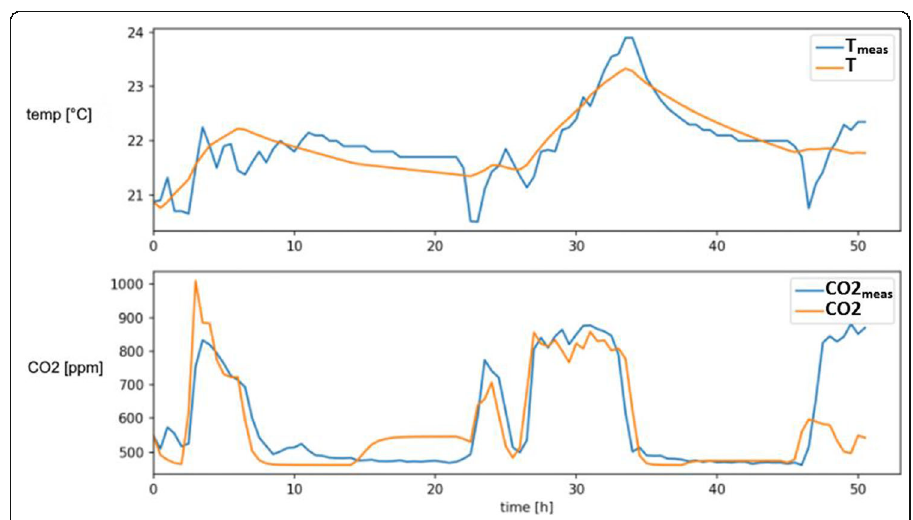
Fig. 6 Measured vs. simulated indoor temperature and CO2 yielded by a calibrated zone model (orange - model predictions, blue -